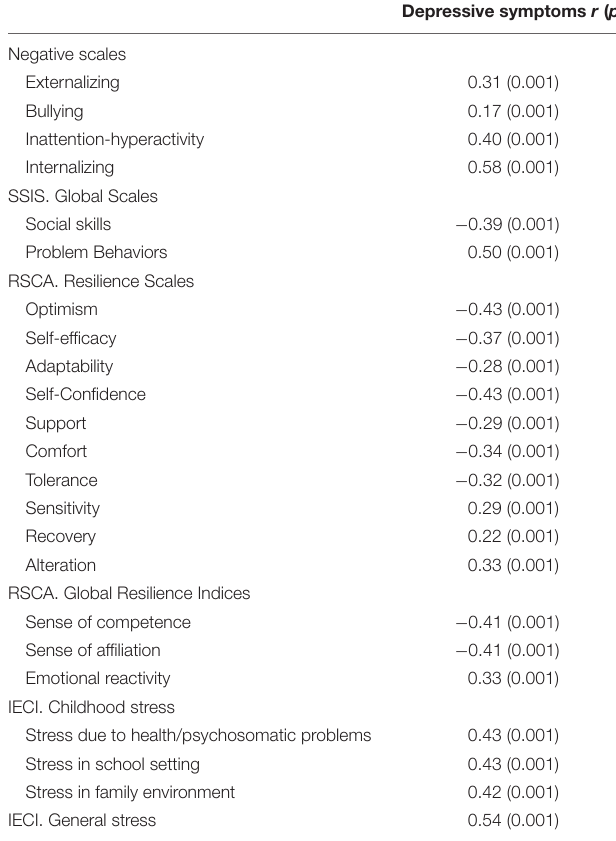
TABLE 2 | Pearson Coefficients correlation between self-assessed depression and adaptive and clinical